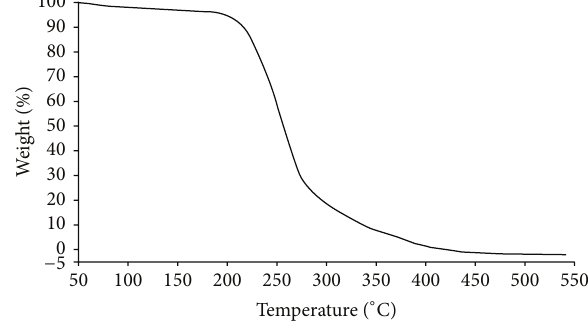
Figure 6: Thermal degradation analysis of BS produced by the L. helveticus